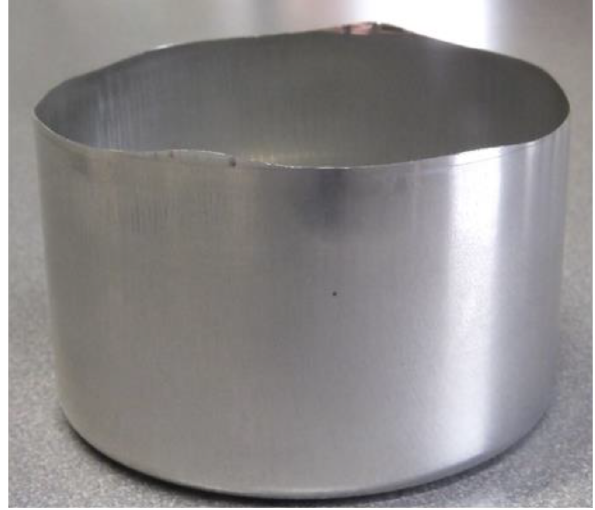
– Creation of 4 ears in 0 ∘ , 90 ∘ , 180 ∘ and 270 ∘